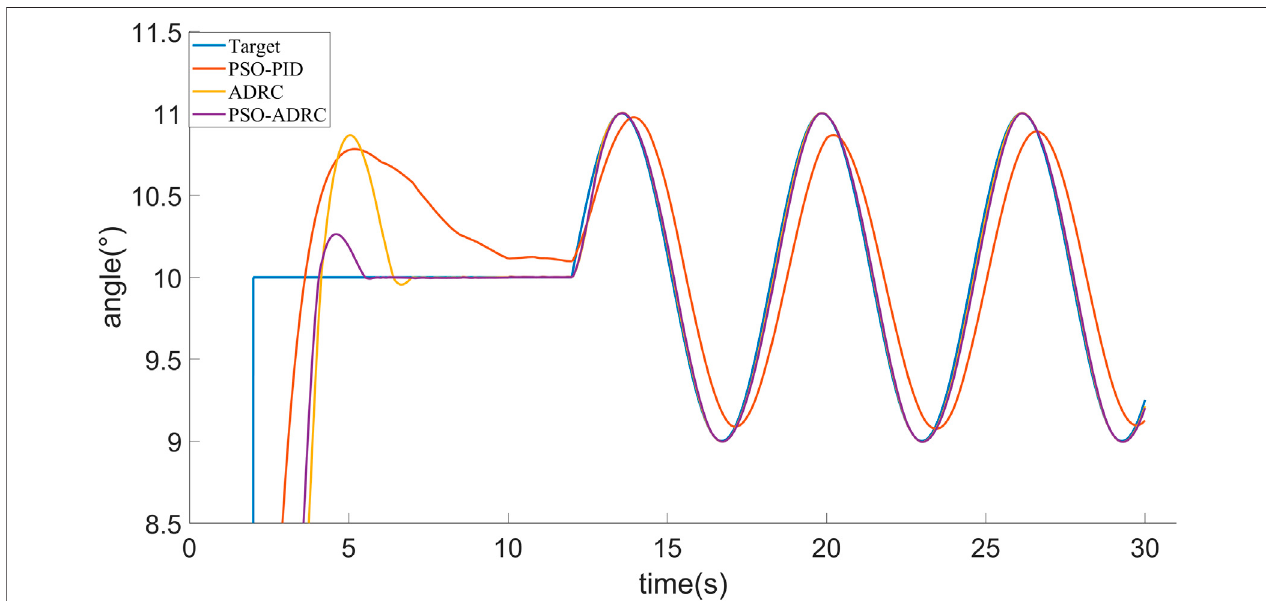
FIGURE 10 | Signal tracking experiment under internal interference.